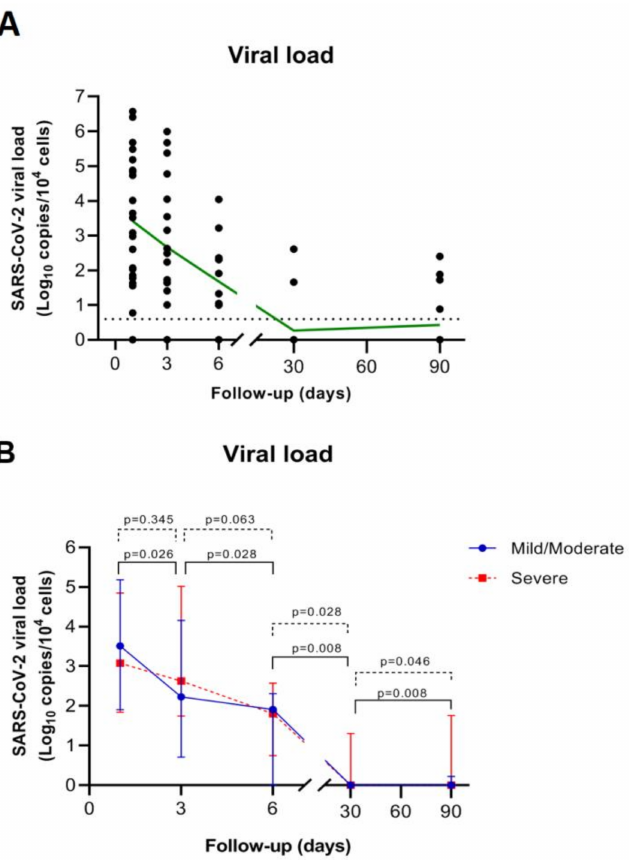
Figure 1. SARS-CoV-2 viral load kinetics. ( A ) SARS-CoV-2 RNA levels among the overall study population during the study period. The black dots represent the aligned individual values obtained from each time point. The green line represents the connected mean values. The dotted line indicates the established experimental threshold (below the lowest positive sample obtained in our study). ( B ) Median SARS-CoV-2 RNA levels in patients with mild/moderate versus severe COVID-19. The solid blue line with circles represents the mild/moderate group and dotted red line with squares represents the severe group. Wilcoxon signed rank test was performed for the decline of viral load between time points; p: p